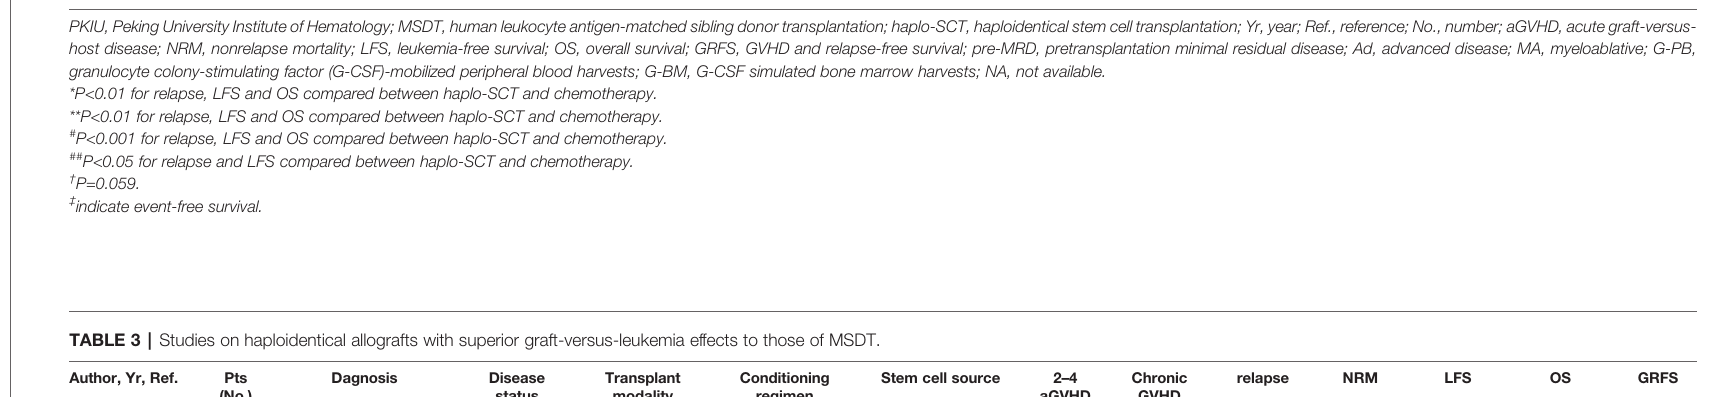
TABLE 3 | Studies on haploidentical allografts with superior graft-versus-leukemia effects to those of MSDT. Author, Yr, Ref.